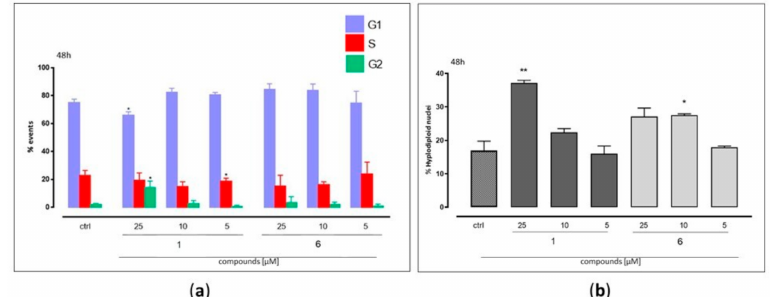
Figure 3. Cell cycle analysis: ( a ) DNA content and ( b ) hypodiploid nuclei, with propidium iodide staining, were evaluated by flow cytometric assay. A375 cells were treated respectively with 1 or 6 (both 5-10-25 µ M) for 48 h. Results are expressed as mean ± S.E.M. of three independent experiments, each performed in duplicate. Data were analyzed by Student’s t -test. * p < 0.05 and ** p < 0.005 vs. non-treated.